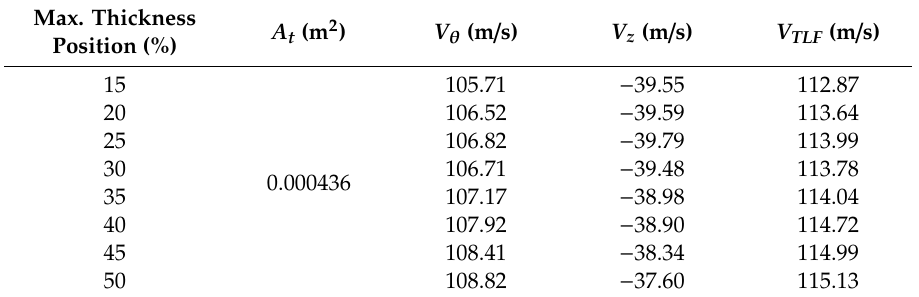
Table 3. Area and velocity components on the meridional plane for tip clearance ( Φ / Φ des = 1.0). Max.